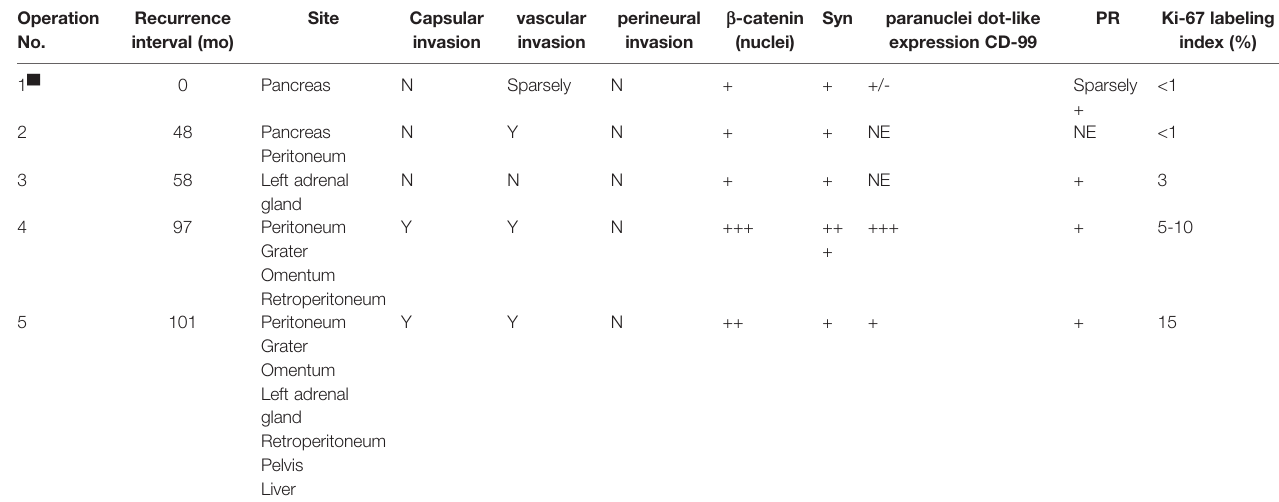
TABLE 1 | Evolutionary characteristics of clinicopathological data of the tumor. Operation